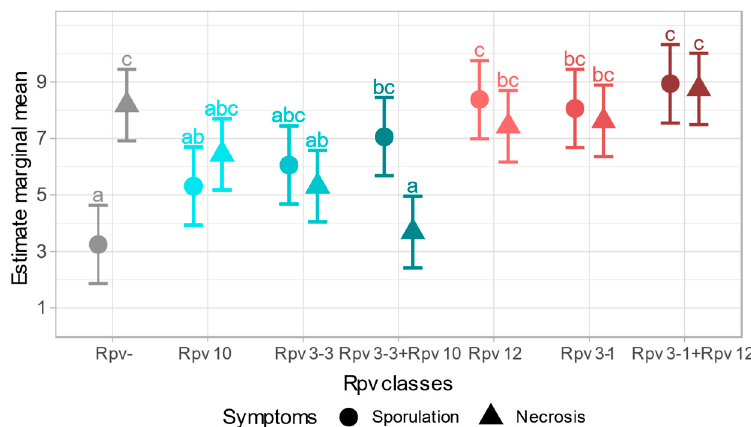
Figure 3. Estimated marginal means calculated by linear mixed models for both sporulation and necrosis reactions. Shades of blue identify the progenies of Solaris (RPxS). Shades of red the progenies of Kozma 20-3 (RPxK). Letters indicate statistically different symptoms among Rpv classes, obtained by pairwise comparisons (Tukey method). Bars indicate standard errors.